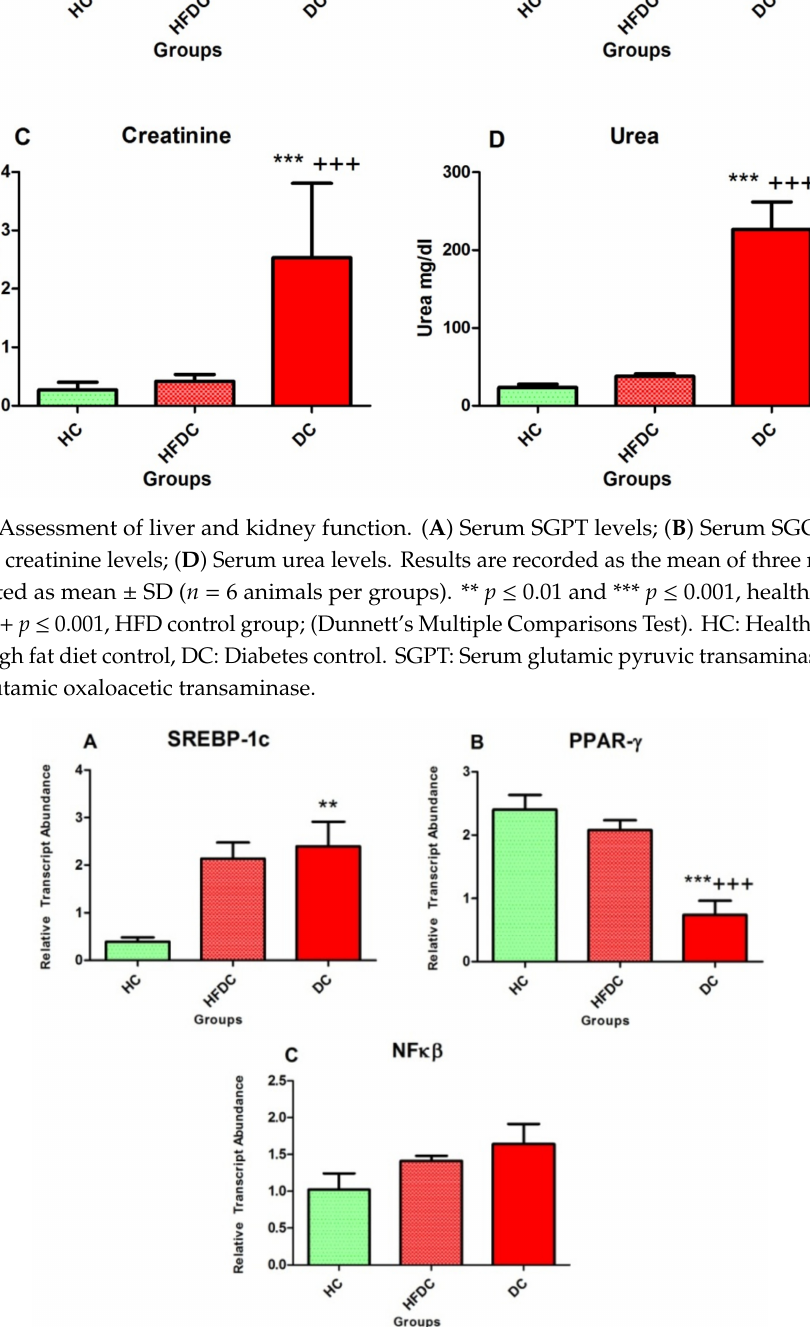
Figure 4. Alteration in transcription factors expression results in lipid abnormalities. Animals from the HC group were fed normal diet while HFDC and DC groups were on high fat diet. DC group